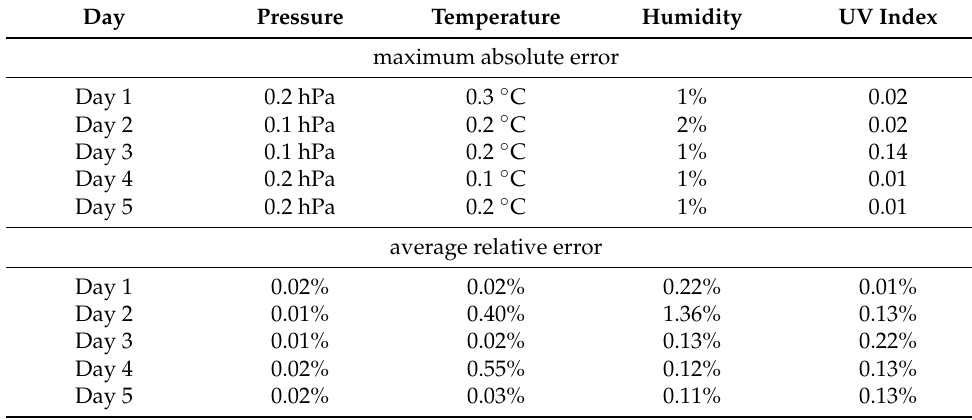
Table 7. Errors occurred during measurements carried out by primary